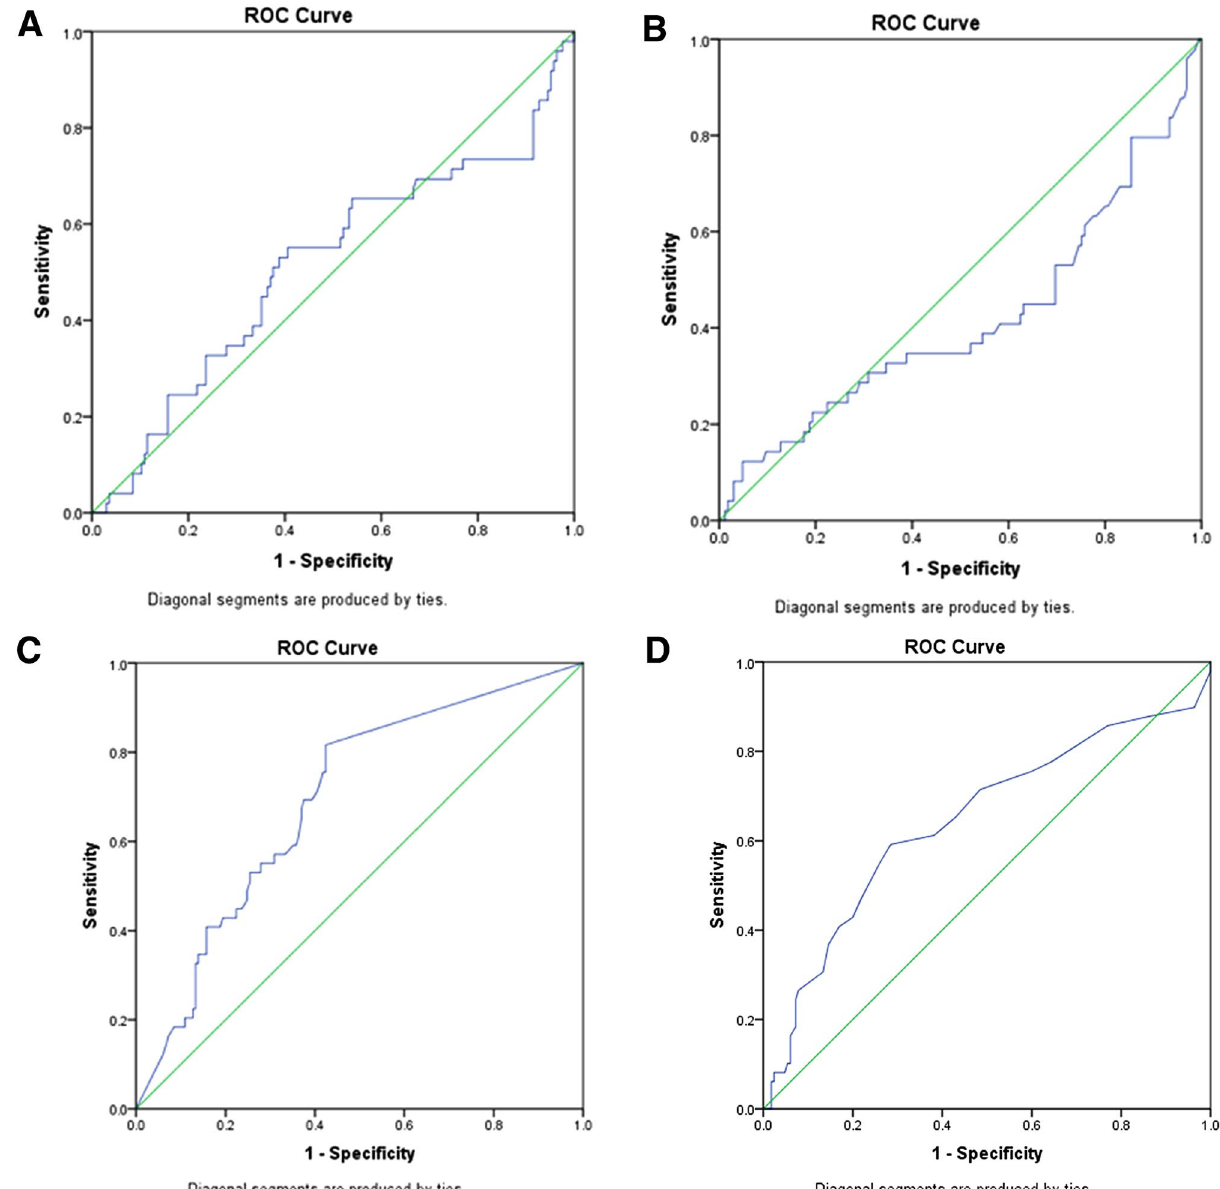
Figure 1. ROC curve of leucocyte count ( A ), platelet count ( B ), C-reactive protein ( C ), and the onset of NEC ( D ) for distinguishing between worsened and improved clinical deterioration of NEC, with the area under the ROC curve of 0.513, 0.418, 0.694, and 0.644,